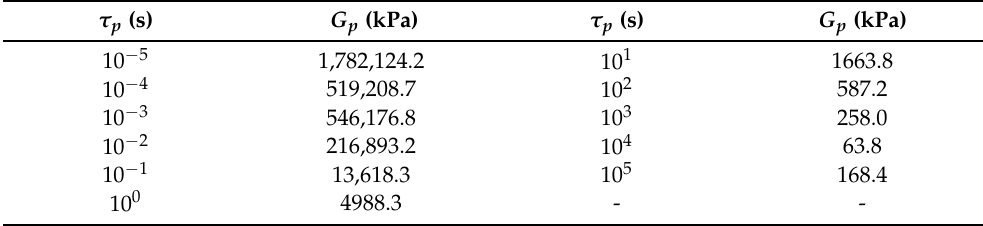
Table 4. Parameters of generalized Maxwell chain model representing PVB foil for reference tempera- ture T 0 = 20 ◦